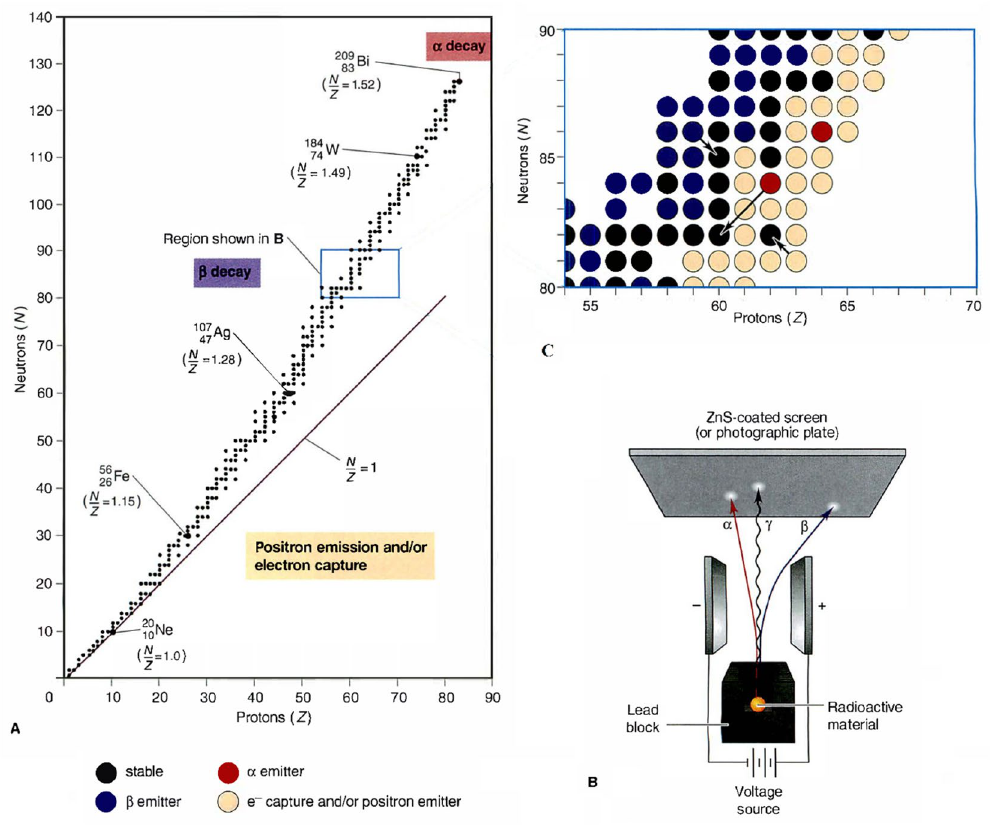
Figure 1. ( A ) Stability band for particles ( B ) Process of emission ( C ) Different types of decay 62